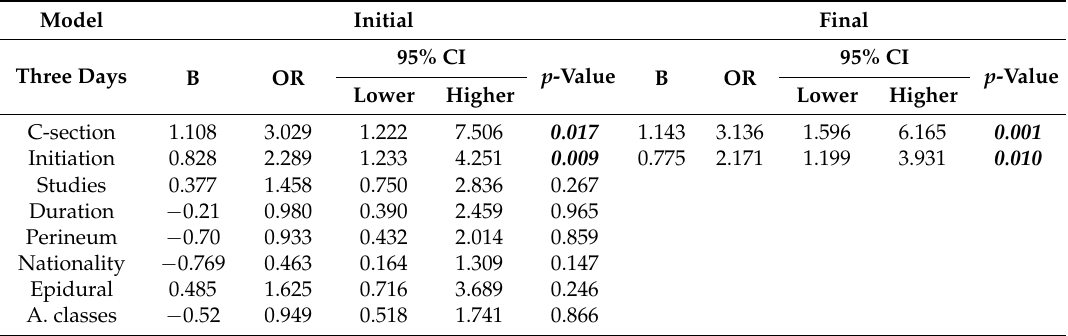
Table 3. Binary regression logistic model, predictors of childbirth experience three days after birth ( n =